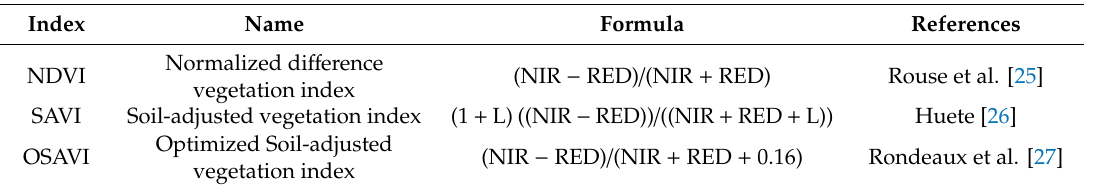
Table 2. Vegetation Indices, Formula, and